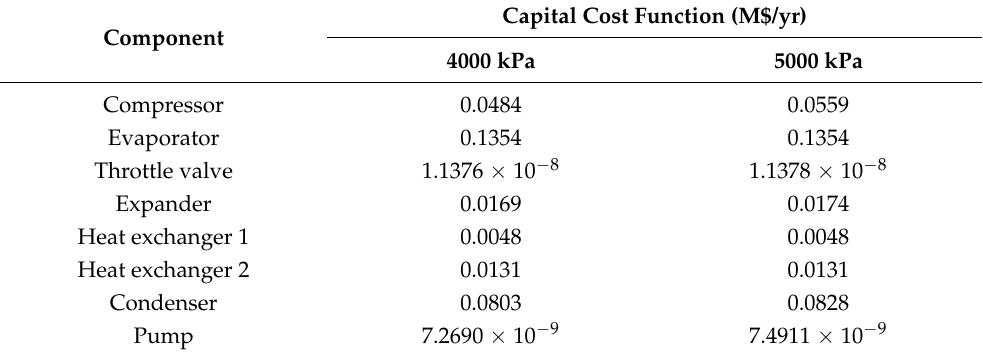
Table 6. The capital investment and maintenance costs of components under the different intermedi- ate